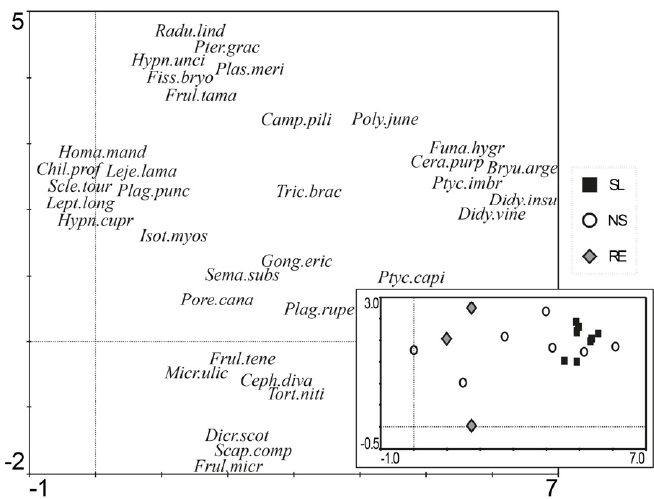
Figure 3. Detrended correspondence analysis (DCA) showing the distribution of bryophyte species (large graph) and ordination of bryophyte communities (small graph). Bryophyte species are indicated by combinations of genus and the species names, as indicated in Appendix A. DCA Axis 1 eigenvalue = 0.874; DCA Axis 2 eigenvalue = 0.353.